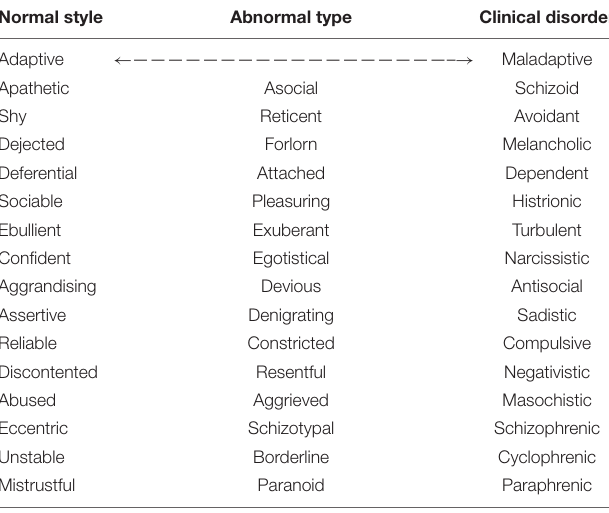
TABLE 1 | Personality prototypes and respective spectra